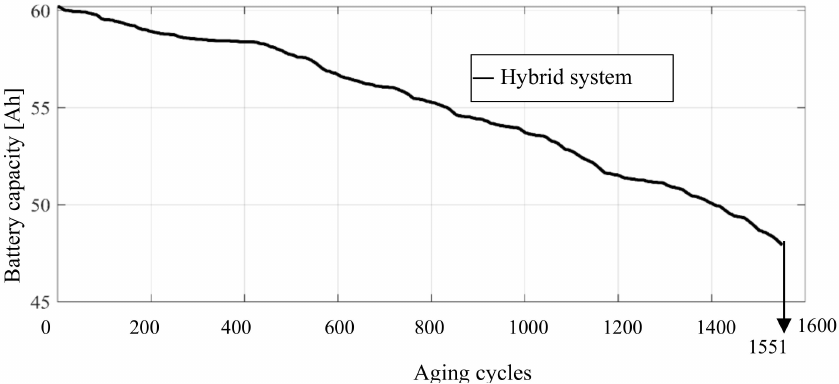
Figure 17. Hybrid storage system: maximum number of aging